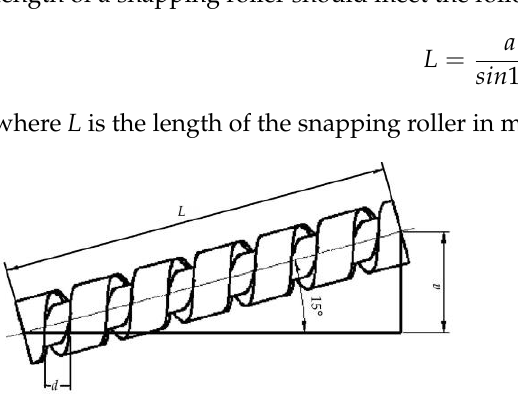
Figure 9. Snapping roller parameters. ( L is the length of a snapping roller in mm; d is the diameter of corn straw in mm; a is the working range in mm )